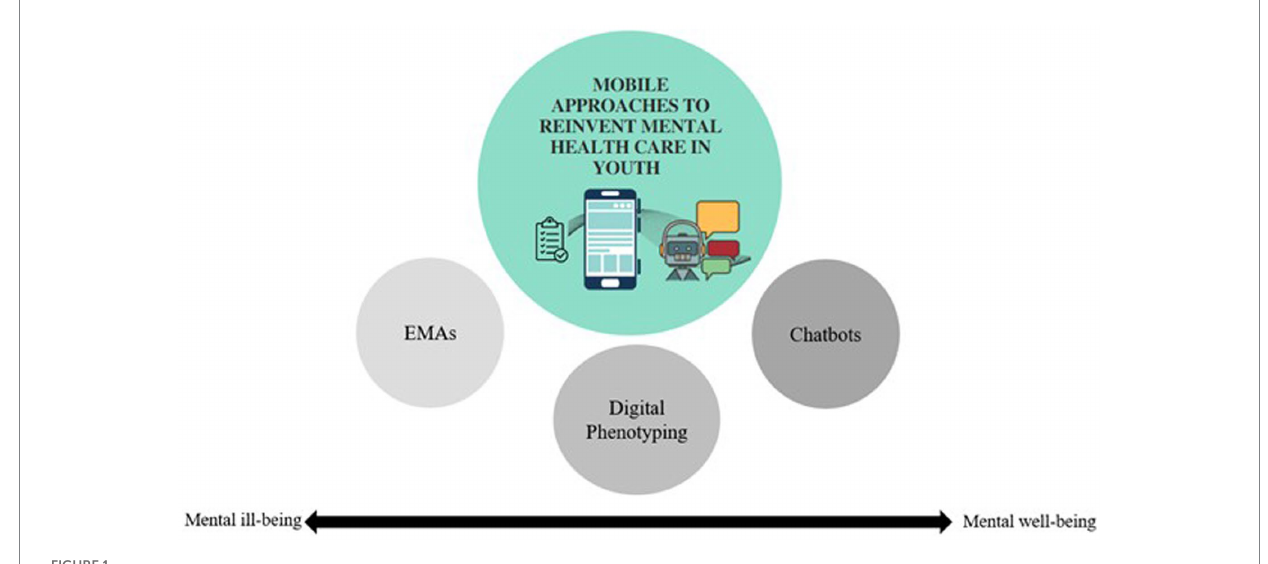
FIGURE 1 Overview of mobile approaches to reinvent mental health care in